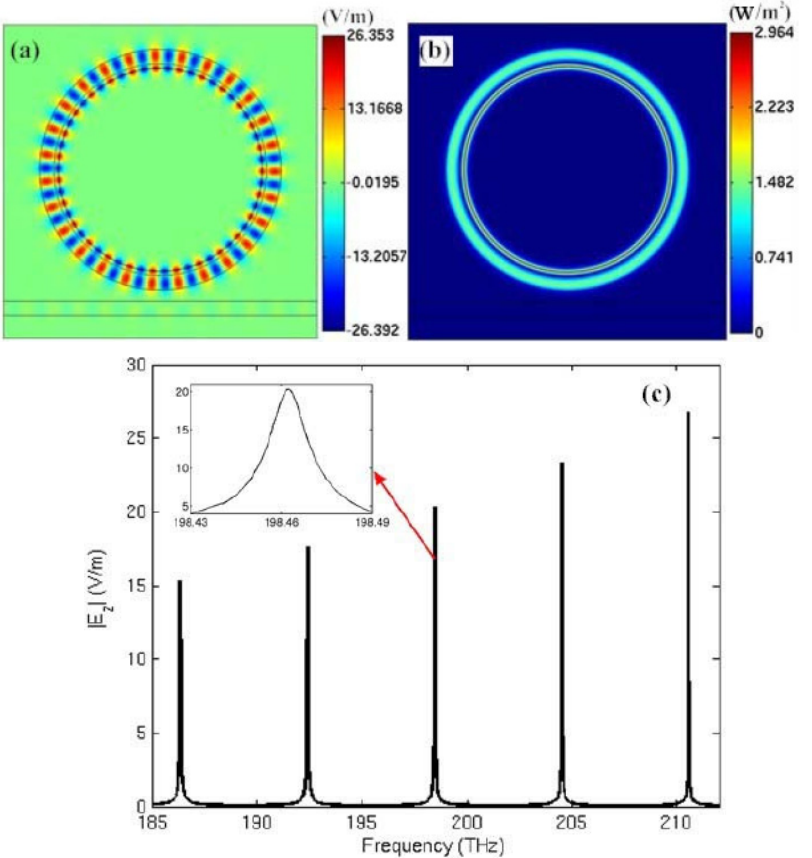
Figure 5. (a) Visualization of the steady-state electric field pattern in the metamaterial sensor at the frequency of f = 198.46THz ( m = 27). (b) The power flow distribution. r (c) The resonant frequency spectrum.